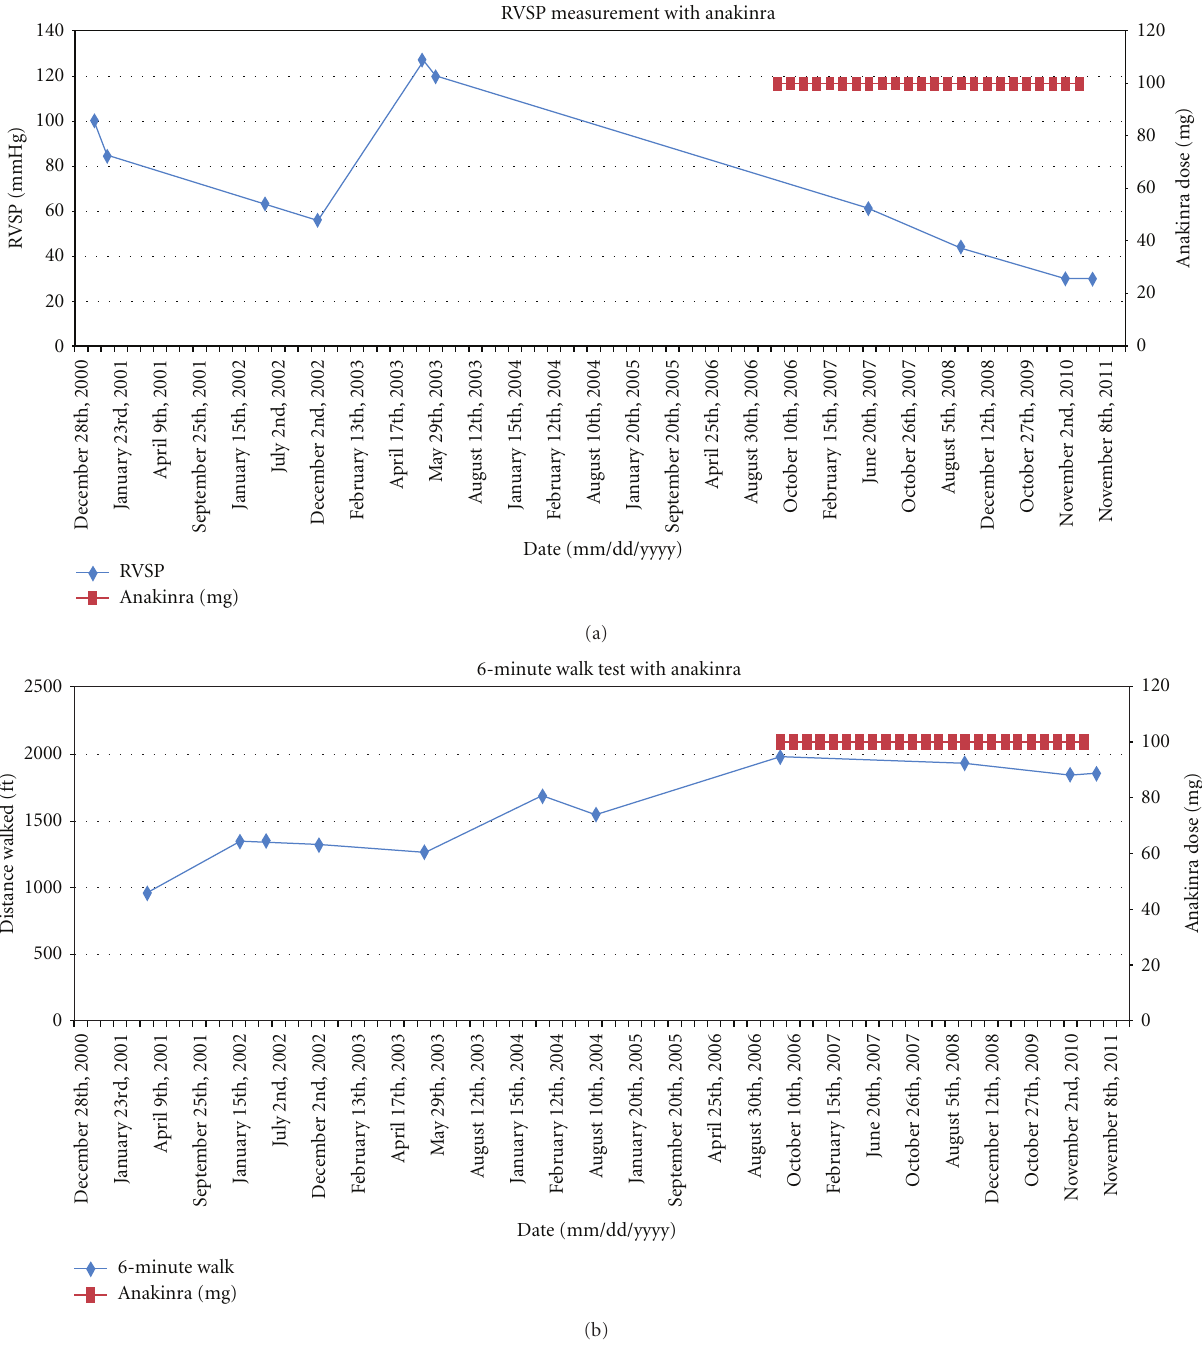
Figure 2: (a) Improvement in 6MWT after anakinra initiation; (b) improvement in RVSP after anakinra initiation. 6MWT: six minute walk test; RVSP:right ventricular systolic